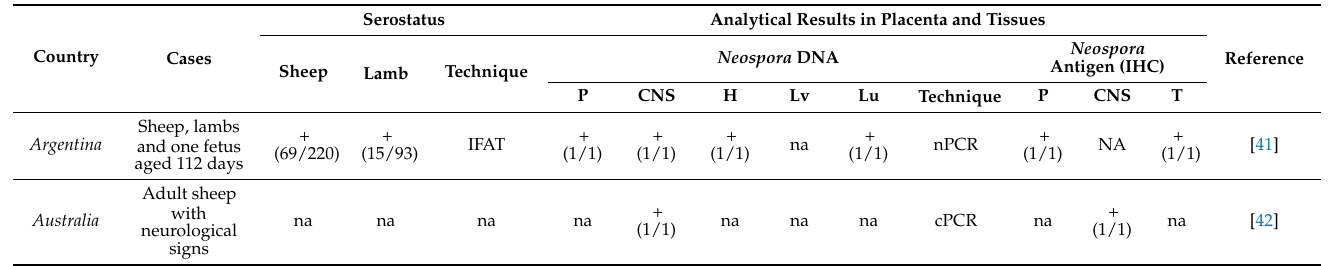
Table 3. Case reports of ovine neosporosis. Serological, molecular and immunohistochemical